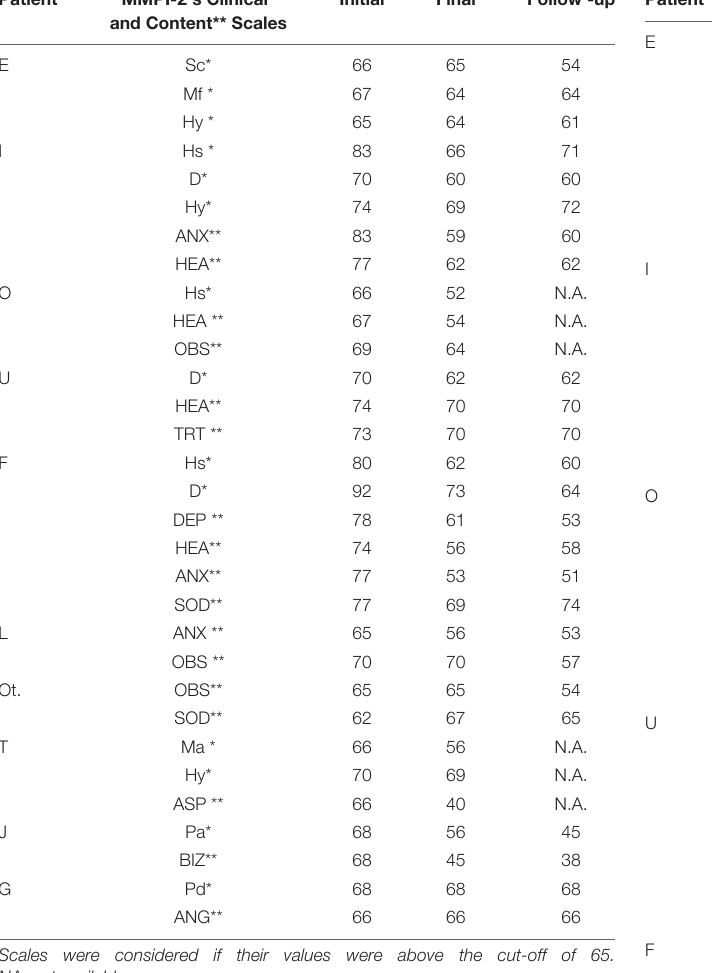
TABLE 5 | MAS Self-Reflexivity data at 4